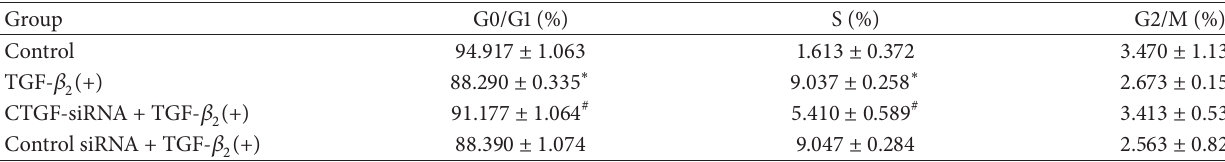
Table 2: Effect of CTGF-siRNA on cell cycle of HTFs.